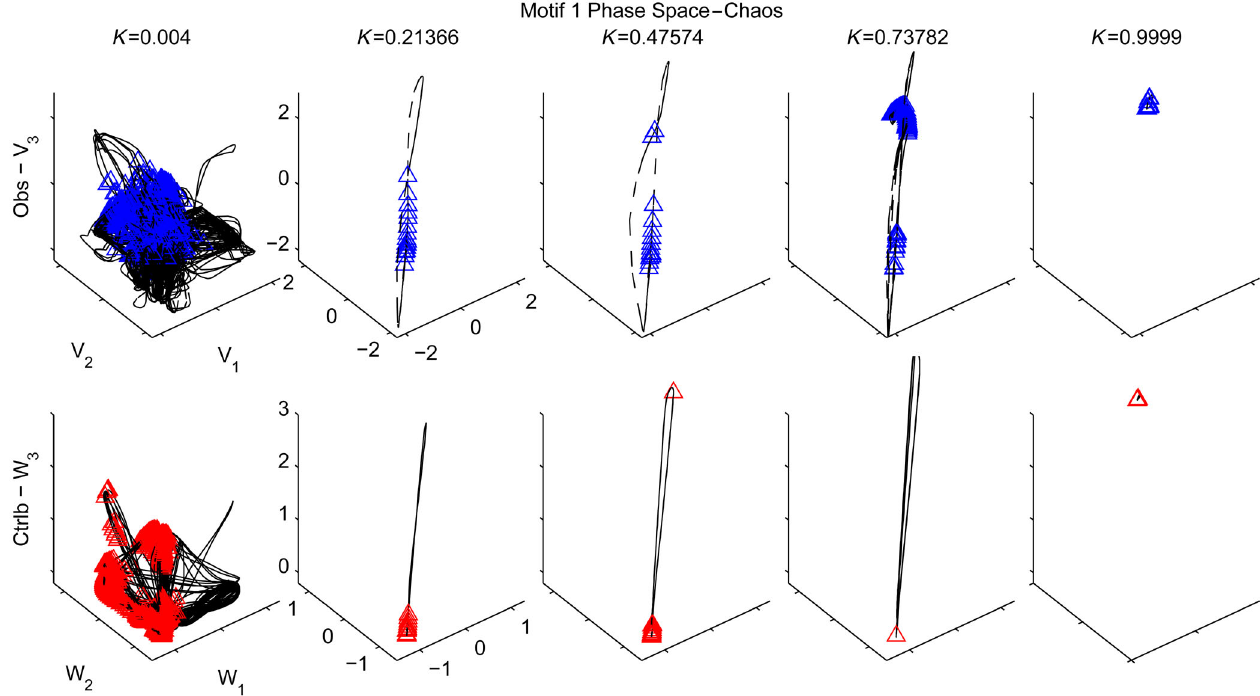
FIG. 7. The three-dimensionalphase spacefor v and w ,showing trajectoriesinmotif 1asmeasuredfrom node1forarange ofconnection strengths (weak to strong heterogeneous coupling K , from left to right, respectively). In the first row, blue triangles mark locations in phase space where observability is higher than the mean for the trajectory, while the second row contains a phase space trajectory for w and red triangles mark the higher than average controllability. The broken symmetry of the heterogeneous network has trajectories that visit locations in the phase space that vary widely in observability and controllability with a log-normal distribution (see the